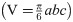
Comparison of measured volume using three-dimensional ultrasound and estimated volume from 2D diameters (V=π6abc) with the true volume of tumor phantoms.A-C) Plots of difference between the volume measurement and estimation against the true volume. The 95% limits of agreement (mean difference ± 1.96 SD) calculated using the Bland and Altman method were indicated as dashed line.